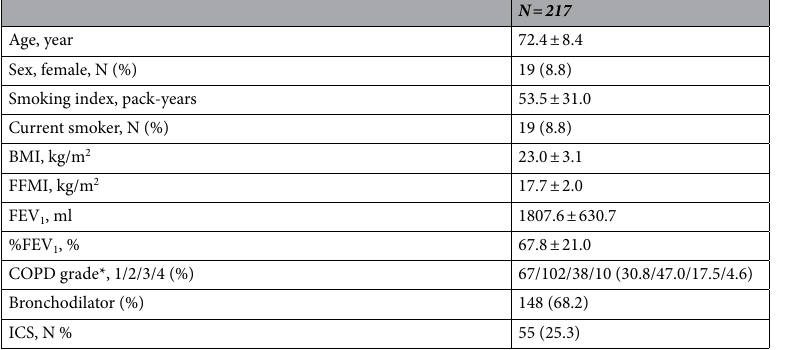
Table 1. Baseline characteristics of the study population. Data are presented as mean ± SD or number (%). BMI body mass index, FFMI fat-free mass index, FEV 1 forced expiratory volume in 1 s, %FEV 1 forced expiratory volume in 1 s as a percentage of predicted forced expiratory volume in 1 s, COPD chronic obstructive pulmonary disease, GOLD Global Initiative for Chronic Obstructive Lung Disease, ICS inhaled corticosteroids. *Defined by the Global Initiative for Chronic Obstructive Lung Disease.